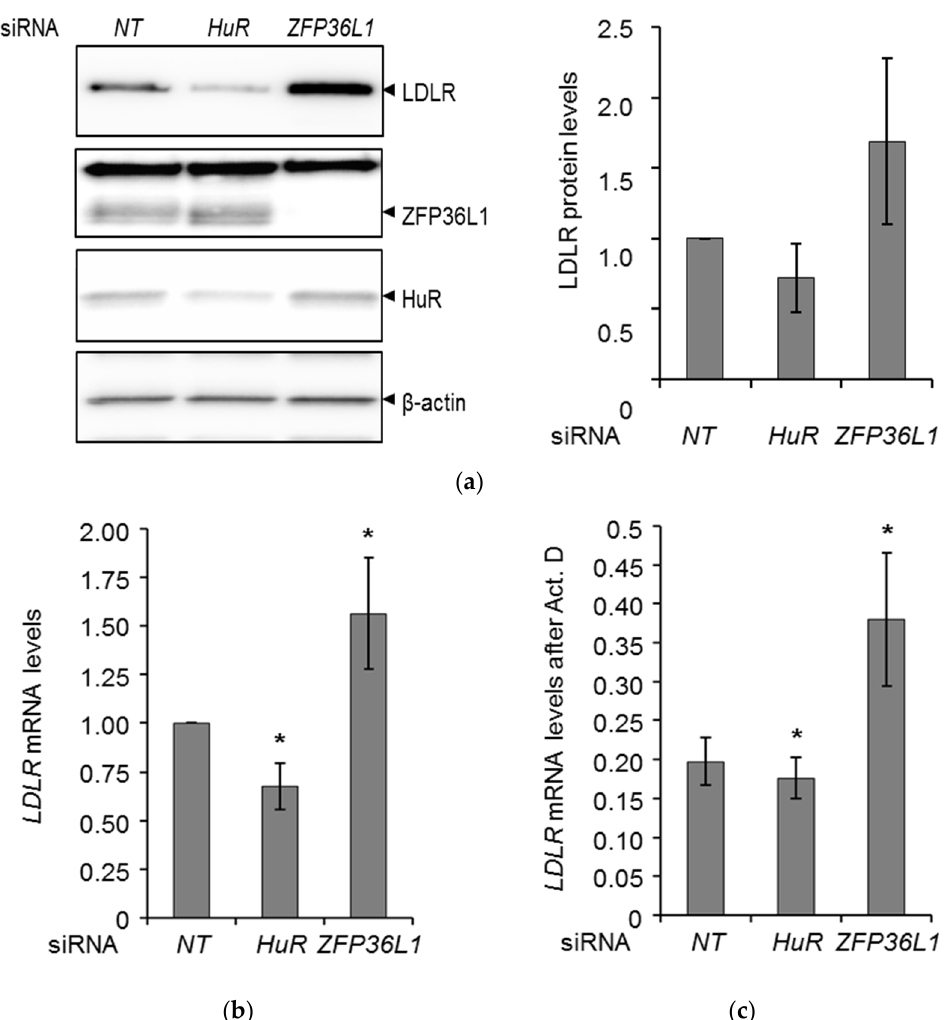
Figure 1. HuR and ZFP36L1 modulate endogenous low-density lipoprotein receptor (LDLR) expression and mRNA stability in HepG2 cells. ( a ) HepG2 cells were transfected with either a non-targeting control ( NT ), HuR or ZFP36L1 siRNAs. Twenty-four hours post transfection, cells were harvested and lysates subjected to immunoblotting using the indicated antibodies. One representative Western blot is shown ( n = 4). The graph in the right panel depicts the intensity of LDLR after normalization to the β -actin protein ( n = 4). ( b ) Twenty-four hours post transfection, cells were harvested and total mRNA was extracted and subjected to quantitative RT-PCR (qPCR) using primers specific to LDLR, ZFP36L1, HuR, and GAPDH mRNA. Error bars show standard deviation of the mean. * p < 0.05, n = 9. ( c ) Twenty-four hours post transfection, cells were incubated with Act D, or not, for four hours. Cells were harvested at time zero (without Act D) and after four hours, respectively, and subjected to total RNA-extraction and qPCR of LDLR mRNA, normalized to GAPDH mRNA. The graph shows the LDLR mRNA level remaining after four hours Act D treatment, relative to NT siRNA-transfected control cells. Error bars show standard deviation of the mean. * p < 0.05, n = 5.